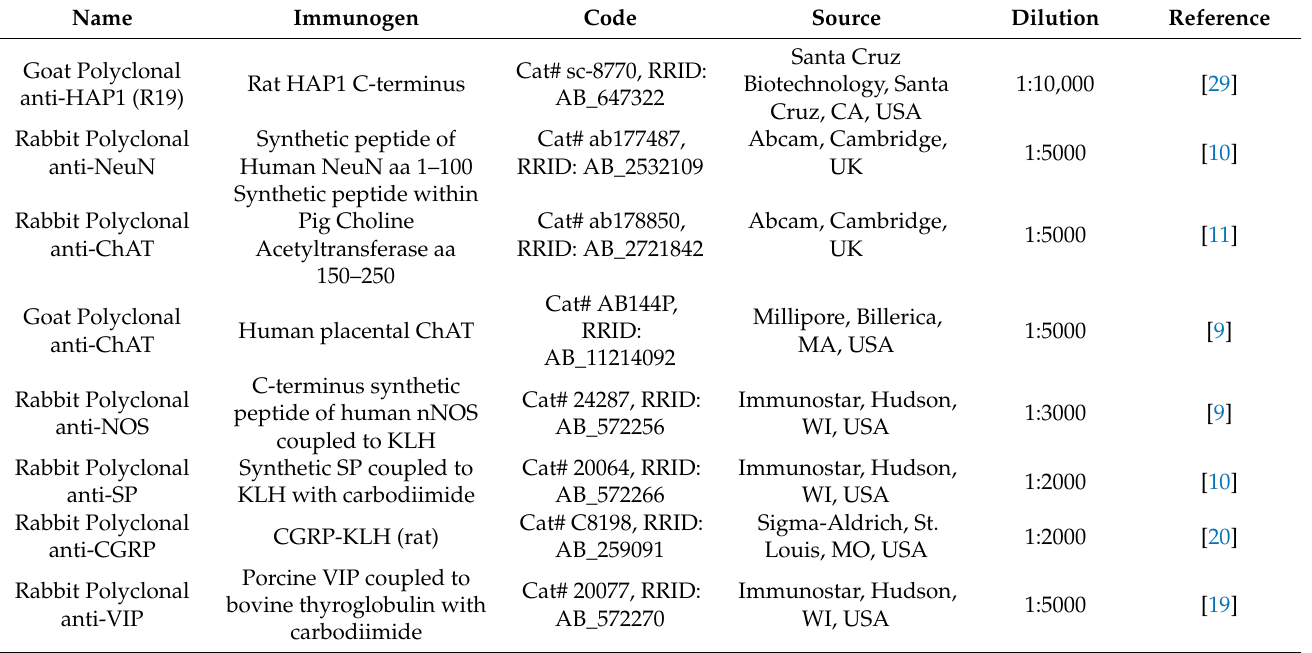
Table 1. Details of primary antibodies used in the current